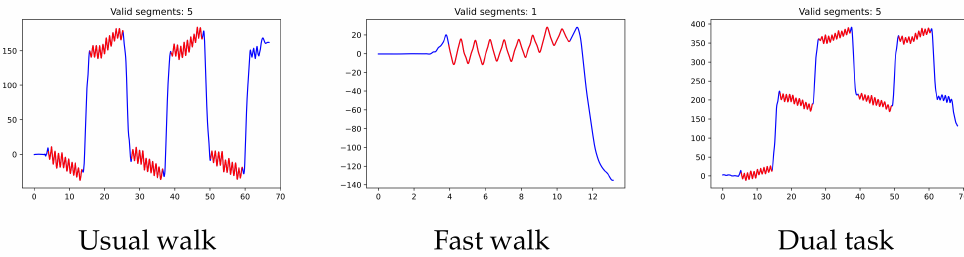
Figure A2. A participant in the HC group, all experiments. In blue, pelvis rotation values; in red, the ambulation time identified by the